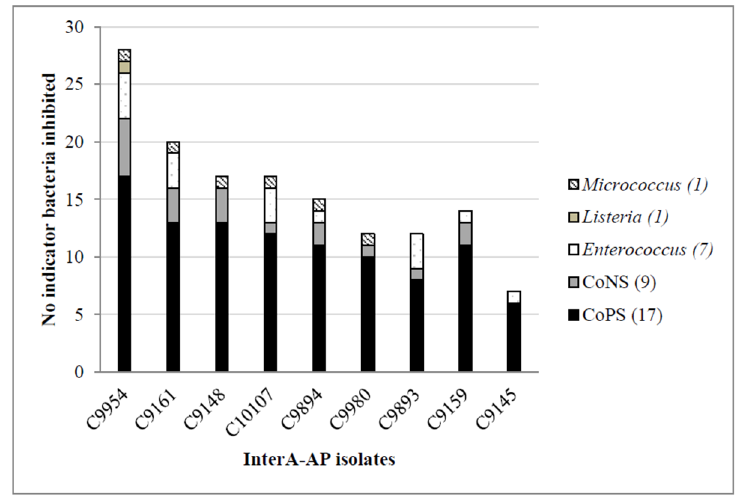
Figure 2. Antimicrobial profile summary of the 9 high antimicrobial-producers S. lugdunensis iso- lates with a broad Interespecific Activity (InterA-AP). Abbreviations: CoPS, coagulase-positive Staphylococcus ; CoNS, coagulase-negative Staphylococcus .